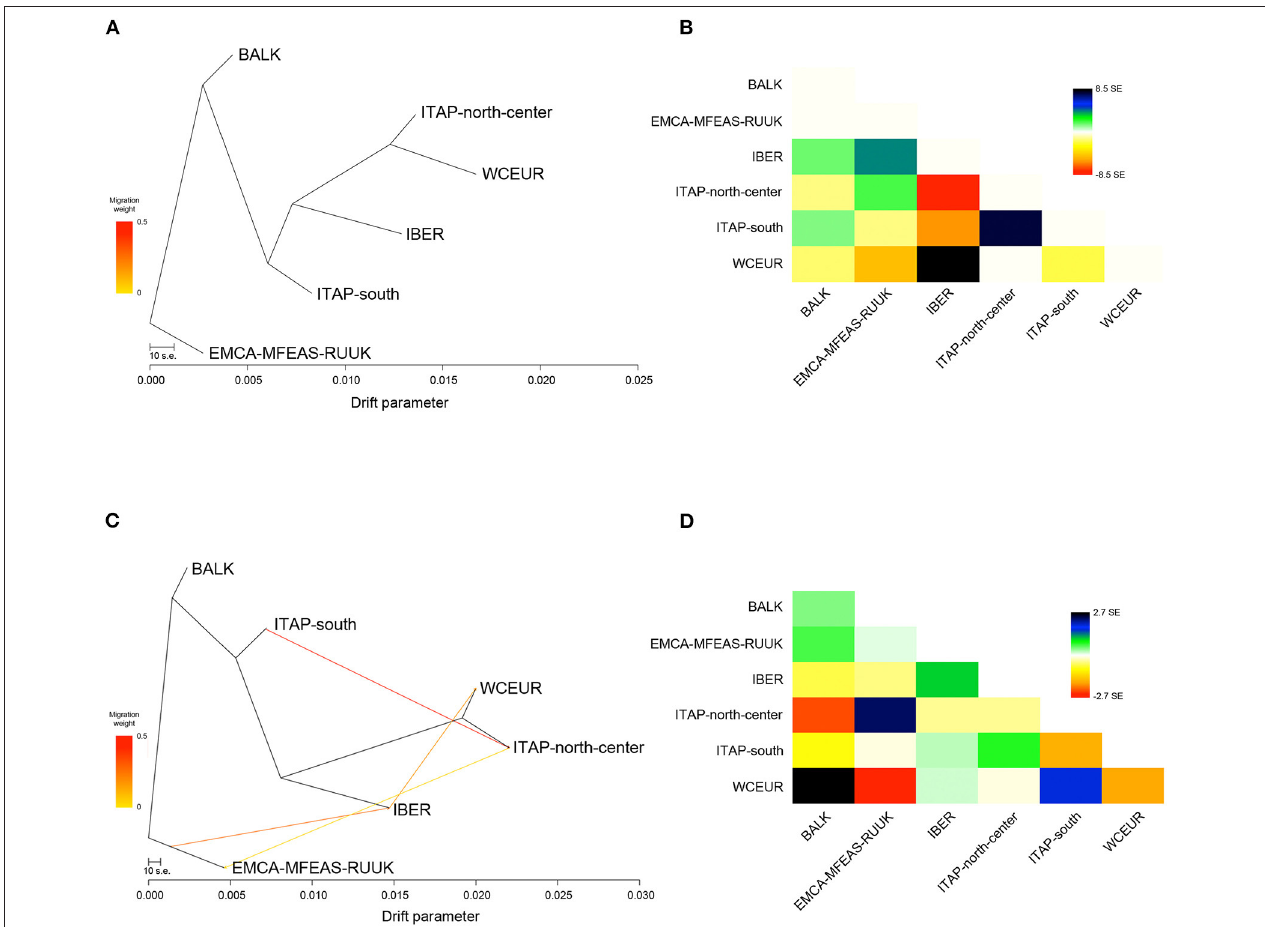
FIGURE 4 | (A) The ML-tree inferred by TreeMix. The scale bar shows 10 times the average SE of the entries in the sample covariance matrix. Drift parameter is shown on the x-axis. (B) Residual fit from ML-tree with SE ± 8.5. High standard errors suggest strong candidate groups for admixture events. Positive residuals characterize groups where the model underestimates the observed covariance; similarly, pairs of groups where the model overestimates the observed covariance showed negative residuals. Colors are described in the palette on the right. (C) ML-tree that best fits the data with 4 additional migration edges: EMCA-MFEAS-RUUK to IBER ( p << 0.001), ITAP-south to ITAP-north-center ( p << 0.001), IBER to WCEUR ( p << 0.001), and ITAP-north-center to EMCA-MFEAS-RUUK ( p < 0.001). Migration arrow is colored according to its weight and colors are explained in the palette on the left. (D) Residual fit from ML-tree at m = 4, with SE ± 2.7. ML, maximum likelihood; SE, standard